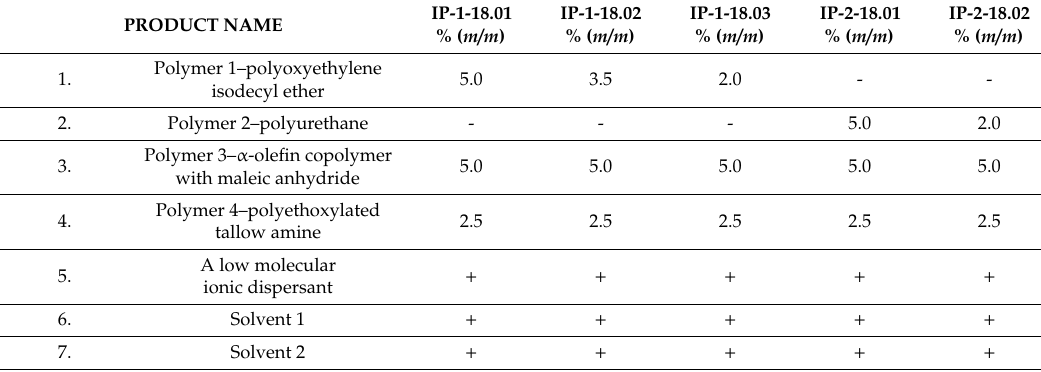
Table 1. Compositions of the developed para ffi n